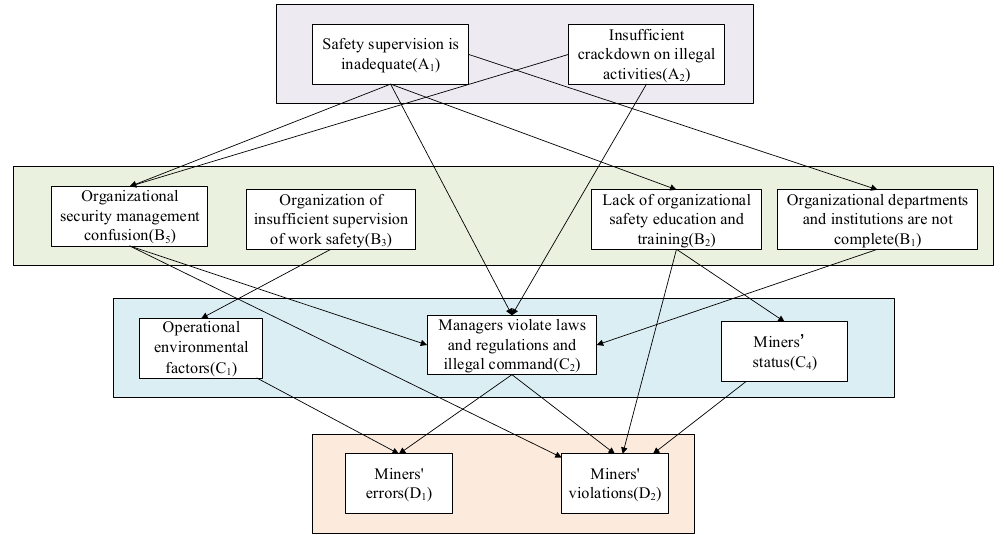
Figure 5. Initial BN model for unsafe acts in gas explosion accidents.